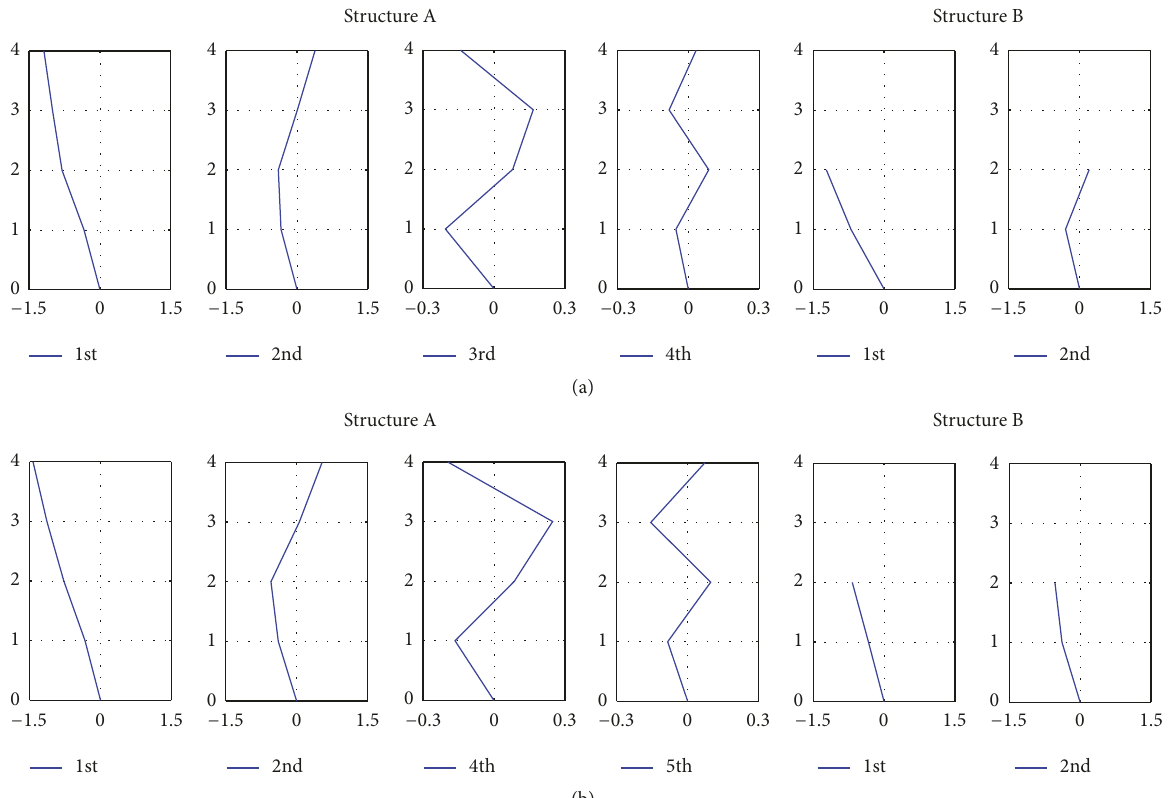
Figure 11: Identified seismic eigenvectors: (a) nonconnected (NC) and (b) rigid connected (RC) configuration. White noise test PGA 0.05 g.